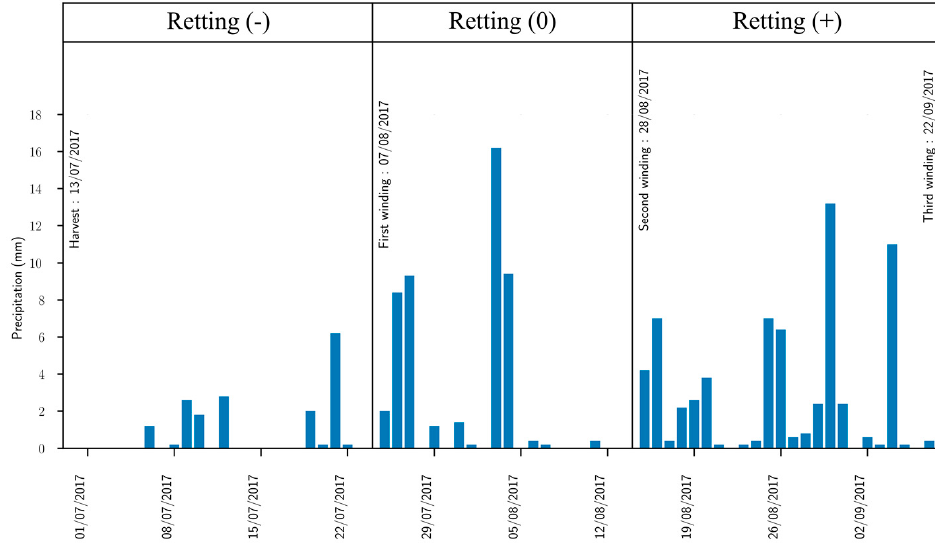
Figure 1. Flax cultivation conditions .